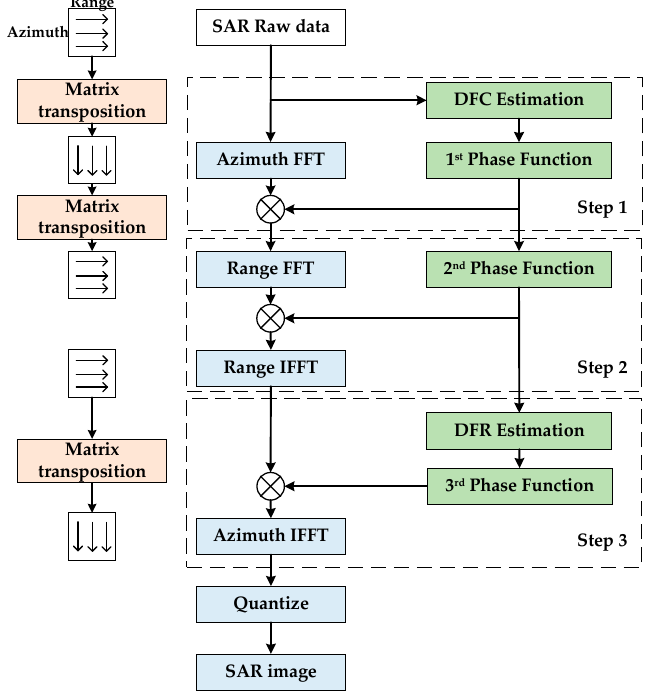
Figure 1. Flowchart of the chirp scaling (CS) algorithm.